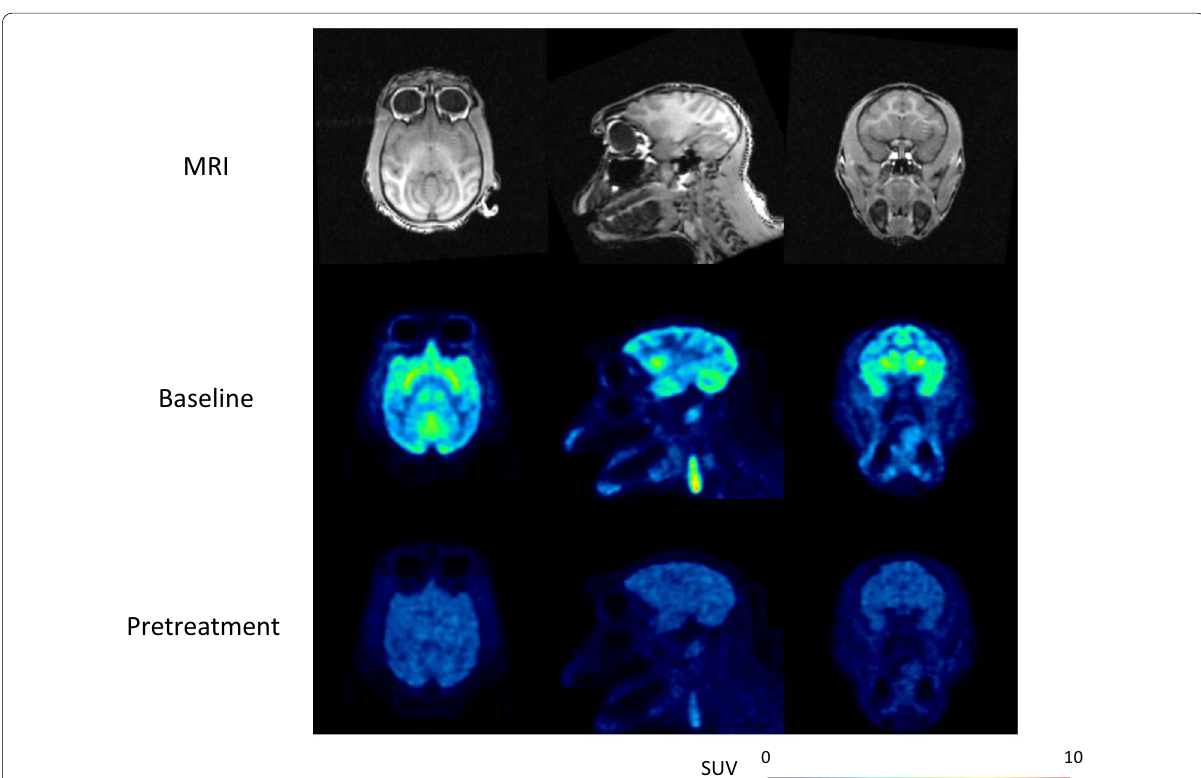
Fig. 1 Representative MRI and PET summation images (0–63 min) of [ 11 C]PF-06809247 at baseline and following pretreatment with a selective MAGL inhibitor (NHP4; 0.42